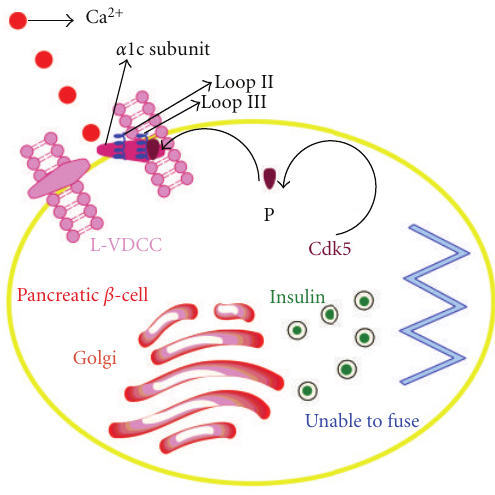
Figure 1: Regulation of pancreatic β -cell function by Cyclin- Dependent Kinase 5 (CDK5). Cyclin-Dependent Kinase 5 (CDK5) is overactivated by high glucose or by signal downstream of tyrosine kinase receptor. The PDX 1 is translocated from nucleus to cytoplasm due to activation of CDK5. That results in the suppression of gene expression by induction of transcription factors such as CCAAT enhancer binding protein β , which acts as negative regulator of insulin gene transcription.